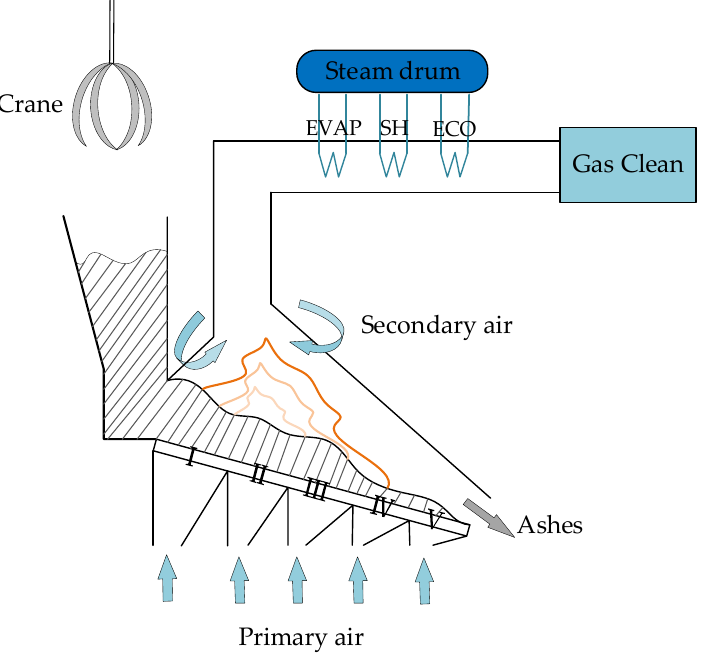
Figure 1. Incinerator structure diagram.